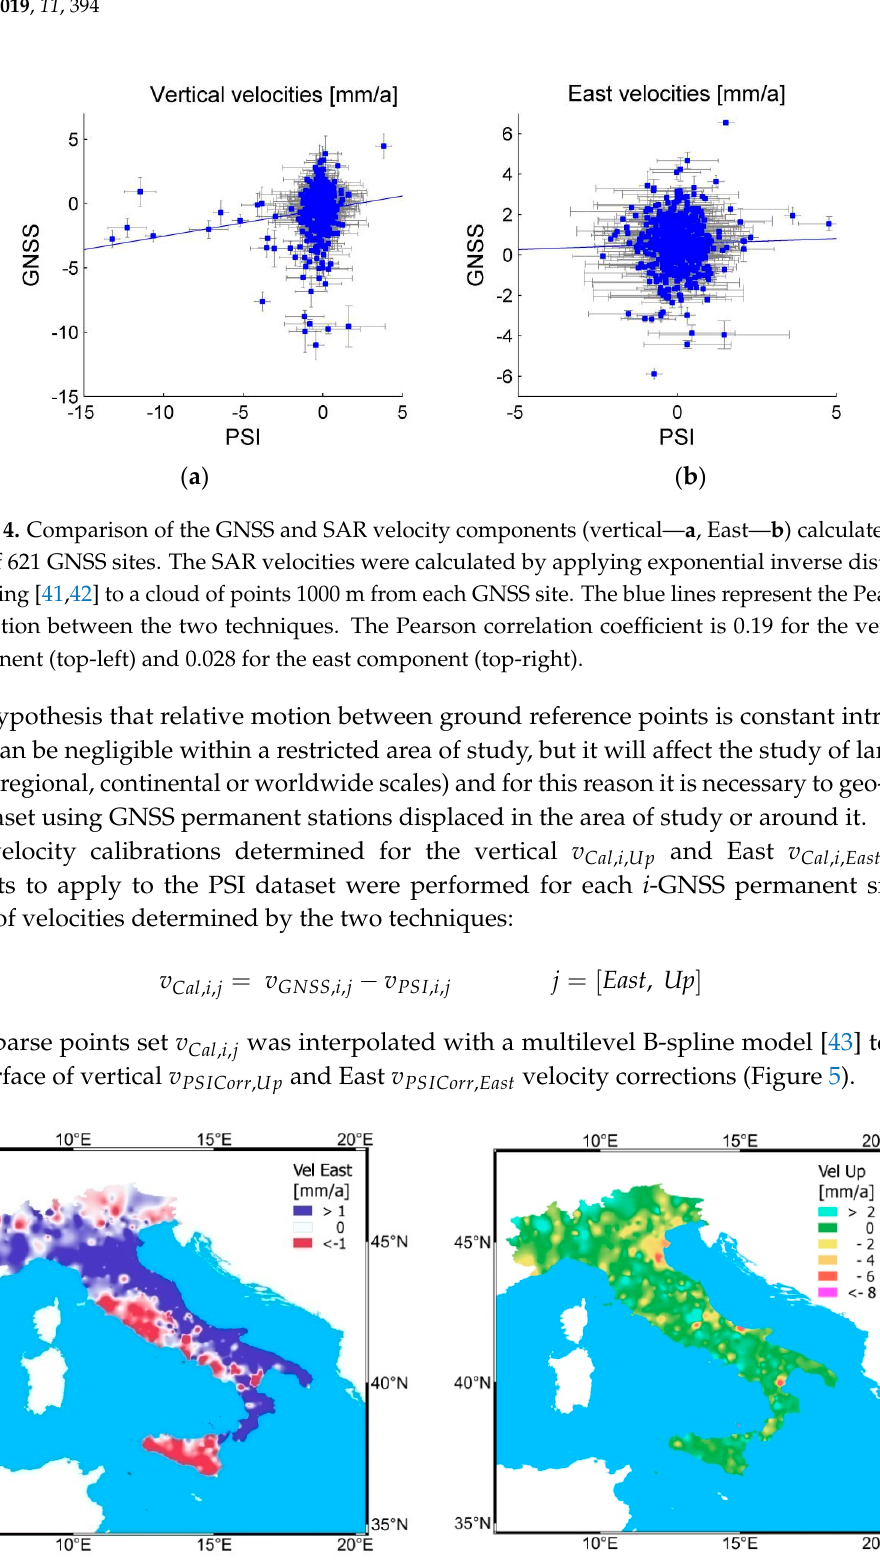
( b ) Figure 3. East component ( a ) and the vertical component ( b ) of the surface ground velocity derived by PS radar interferometry determined the combination of ascending and descending LOS velocities. 7. PS velocity Calibration and Calibration The calibration is based on the comparison of ground point velocities determined using both